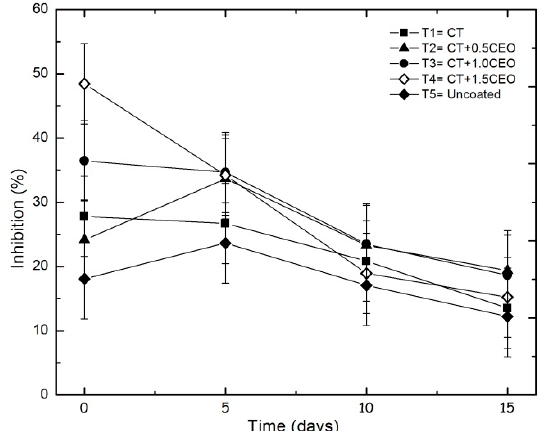
Figure 11. Evolution of antioxidant capacity by DPPH method in strawberries with chitosan (CT) and treatments of oil (TCEO): T1 = CT, T2 = CT + 0.5% of TCEO, T3 = CT + 1.0% of TCEO, T4 = CT + 1.5% of TCEO, and T5 = uncoated throughout a 15-day period. Mean values and intervals of Fisher’s LSD of 95% according to the ANOVA test.